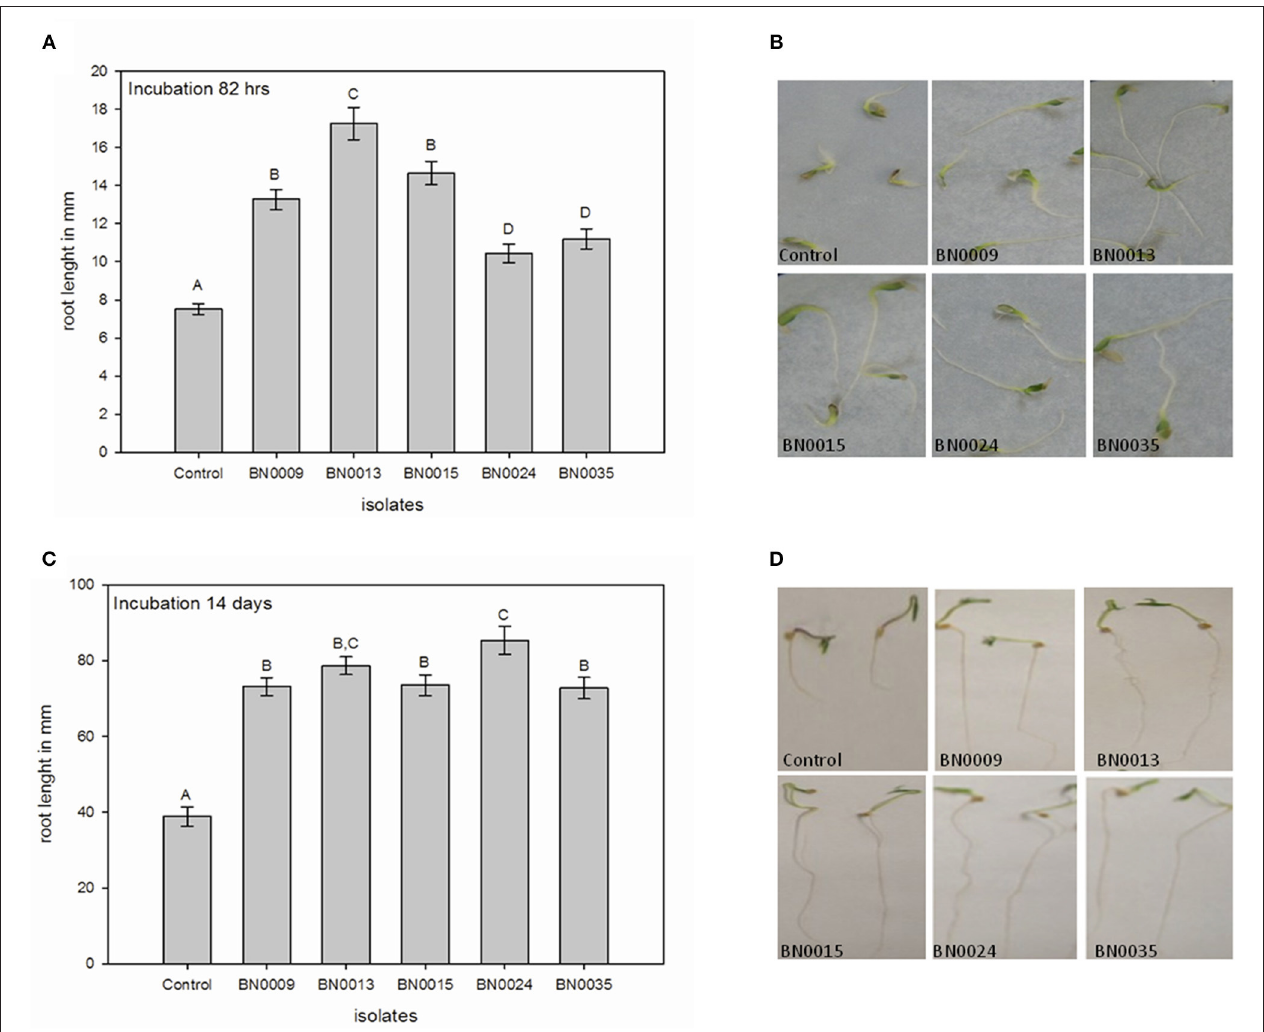
FIGURE 5 | Characterization of the bacterial effects on root extension in lettuce and tomato seedlings; (A) lettuce root length after 82h with 3 statistical groups different from the control (ANOVA-test); (B) photographs of lettuce seedlings after 82h of incubation; (C) tomato root length after 14 days with 2 statistical groups different from the control (ANOVA-test); (D) photographs of tomato seedlings after 14 days of incubation.